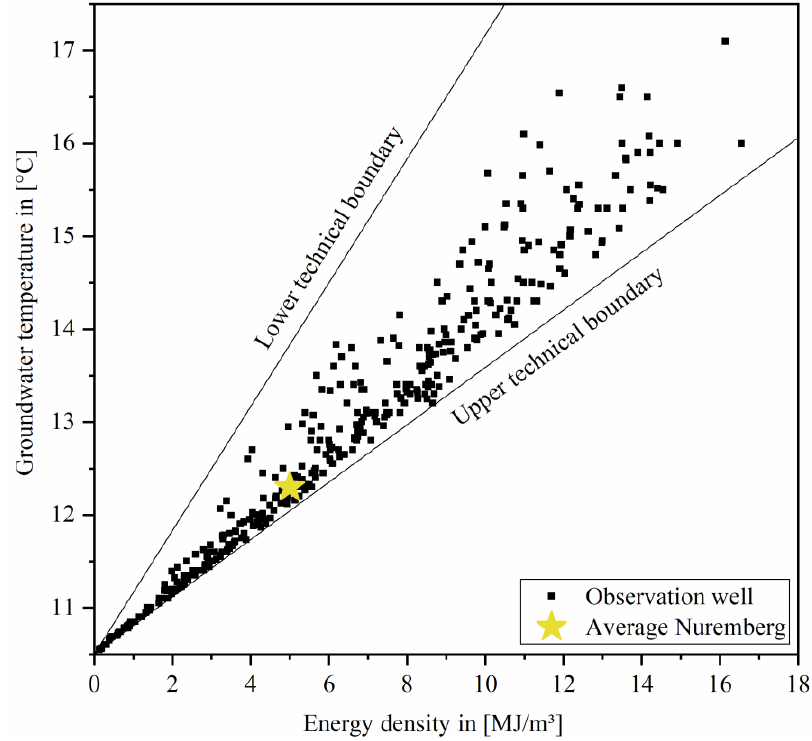
Figure 10. The plot comparing the mean energy density against the groundwater temperatures for all groundwater observation wells. Table 2. Determined hydrogeological and physical parameters for the Nuremberg study